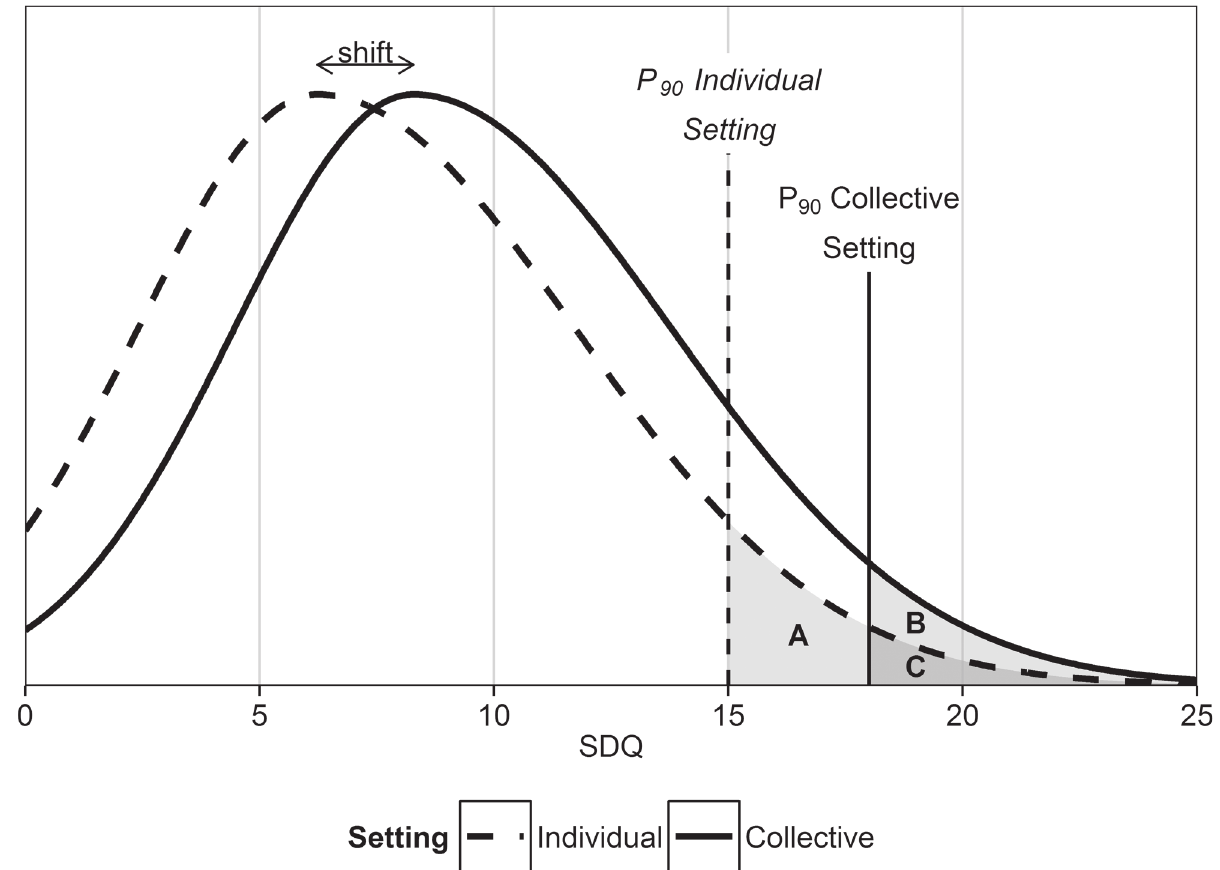
Fig 1. Theoretical density plots for the distributions of the SDQ total difficulties scores for the collective and individual setting, illustrating the shift between the two settings. 90 th percentile cut-off points are given for both settings. Segments illustrate children falling within the abnormal range ( * 10%) of the individual (A+C) and collective (B+C) setting using the respective cut-off points. Children in the individual setting falling within segment C have extreme scores, defined by the cut-off point of the collective